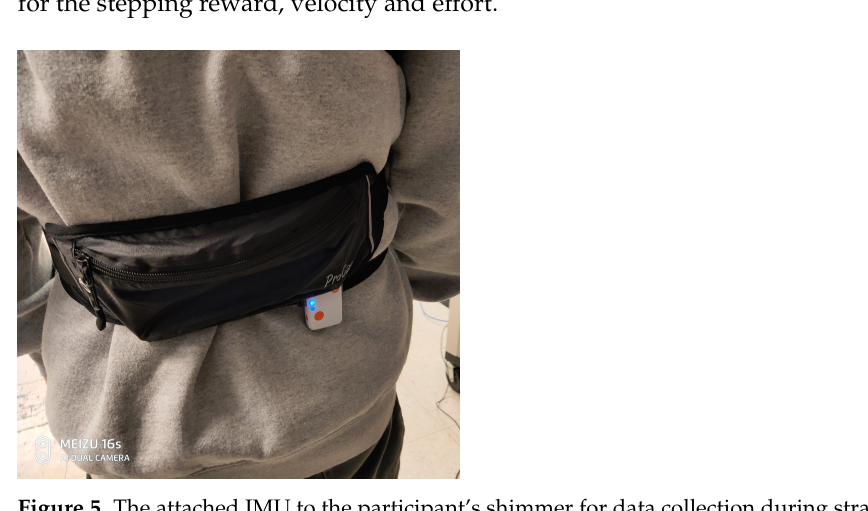
Figure 5. The attached IMU to the participant’s shimmer for data collection during straight